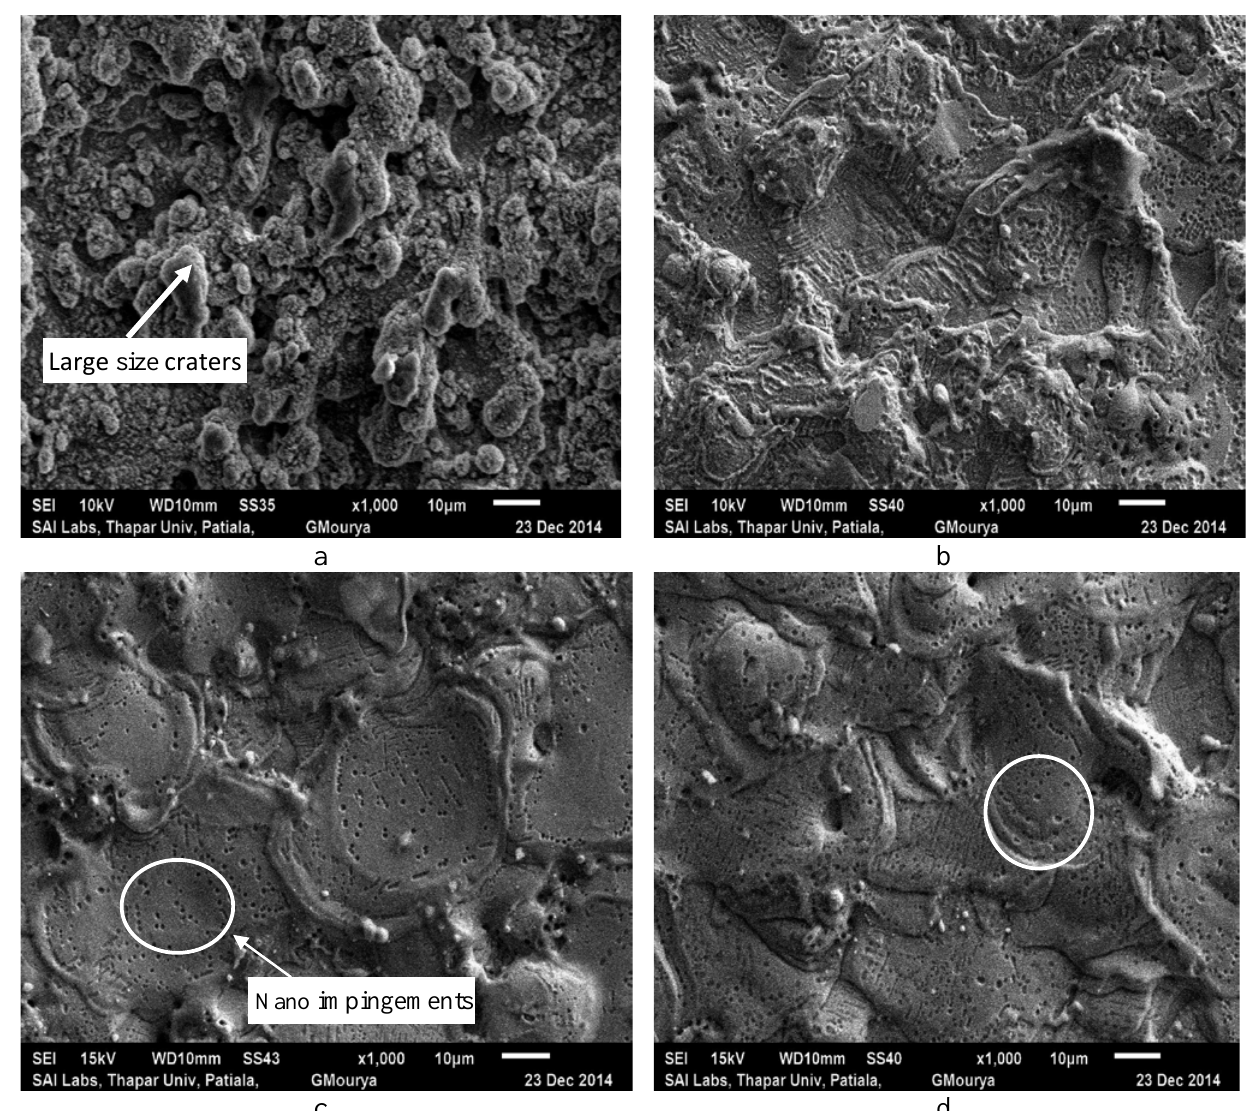
Fig. 6 SEM images of machined surface after (a) rough cut at high DE (b) trim cut (without metal powder) (c) trim cut using 3g/L Al powder in dielectric (d) trim cut using 3 g/L Si powder in